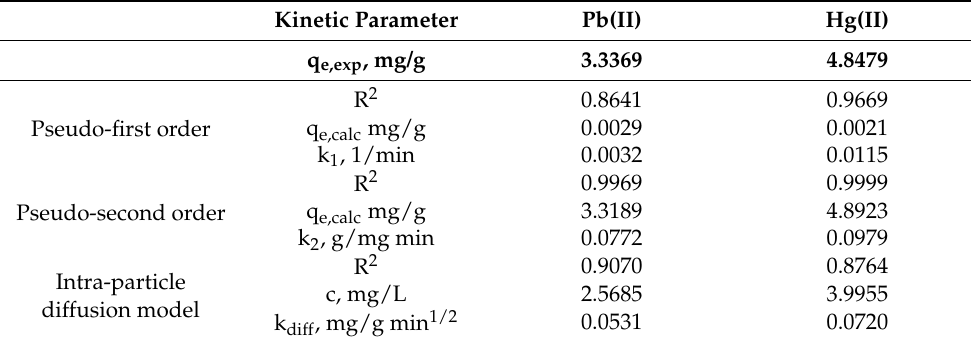
Table 4. Kinetic parameters for the biosorption of Pb(II) and Hg(II) on RWB biosorbent. Kinetic Parameter